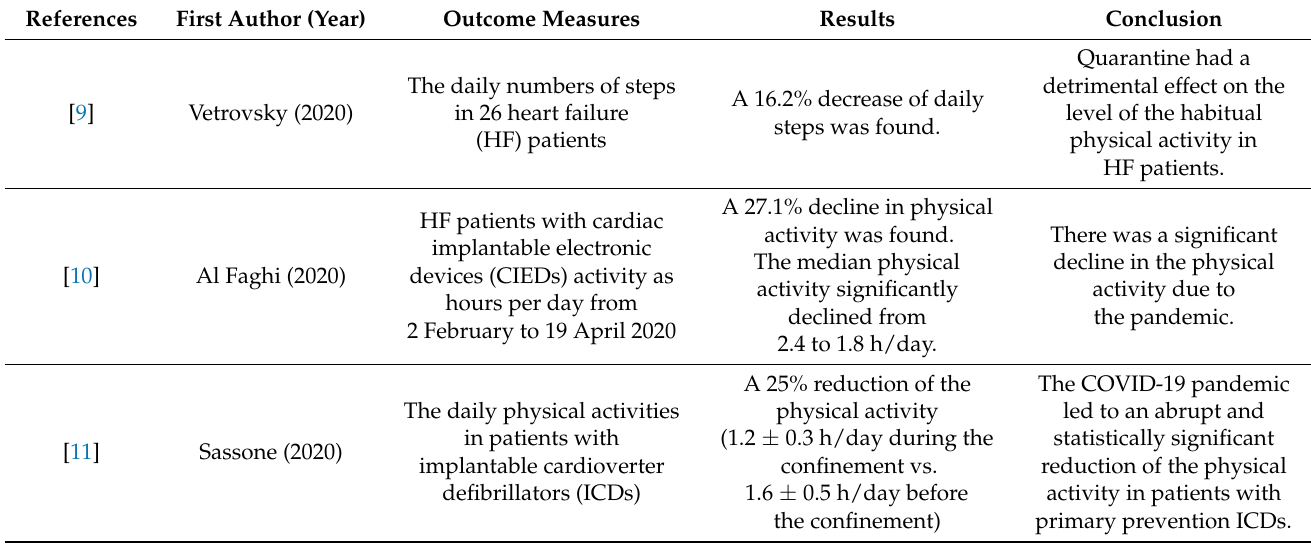
Table 1. Impact of the COVID-19 lockdown in CVD